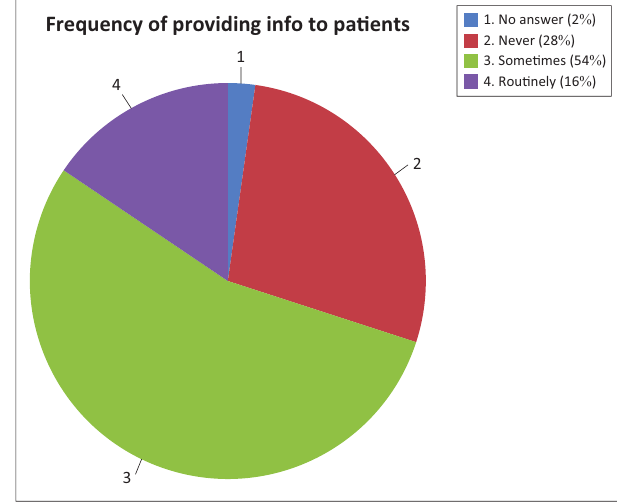
FIGURE 4: Knowledge of ototoxicity per position. FIGURE 5: Participants’ practices with regard to disclosure of